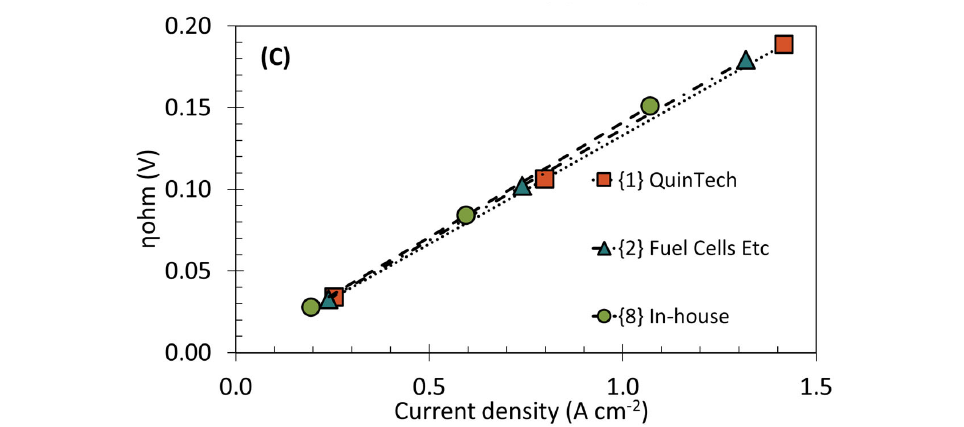
Figure 3. Data of equivalent CCMs from different suppliers operating at 80 °C. ( A ) ‐ I ‐ V curves, ( B ) ‐ activation overpotentials, ( C ) ‐ ohmic overpotentials. ( B ) activation overpotentials, ( C ) ohmic overpotentials.